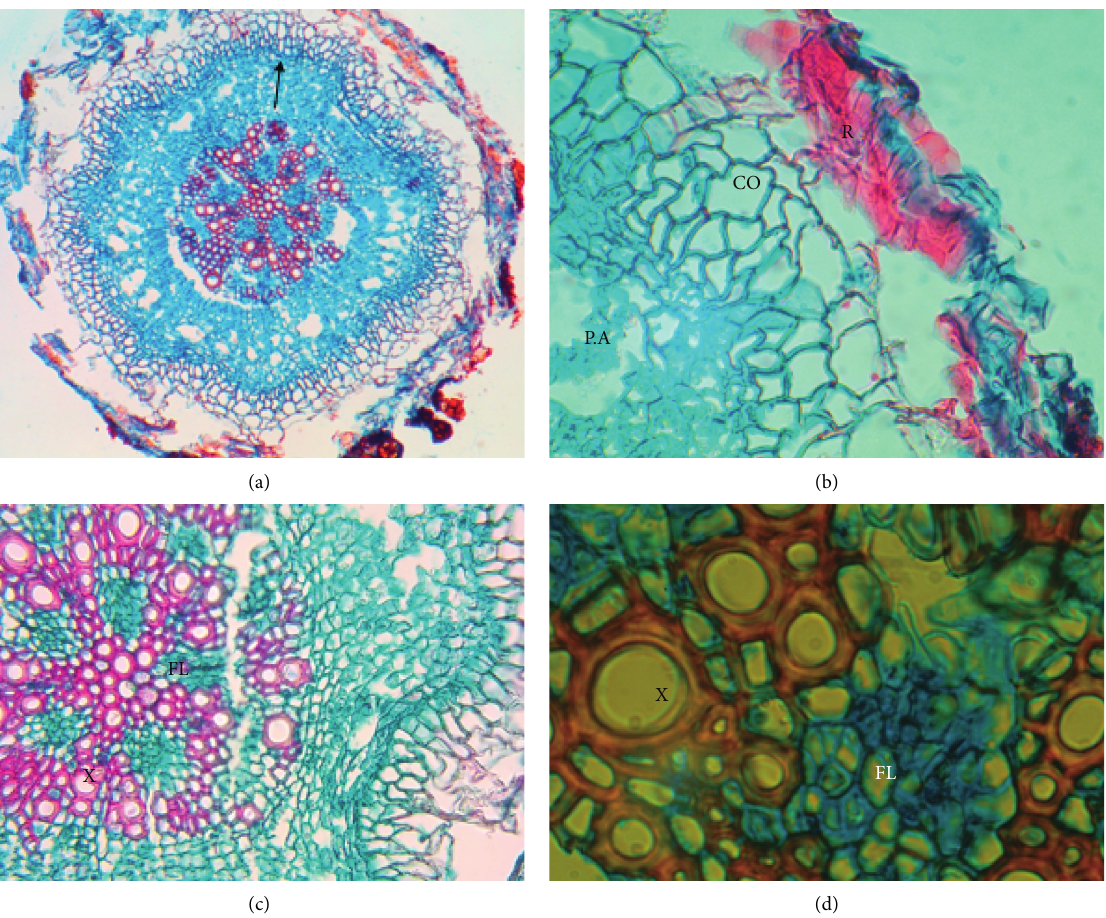
Figure 7: Image of root cross-section of specimen from El Yali National Reserve. General view of the root (a); rhizodermis (R), collenchyma (CO), and aeriferous parenchyma (PA), 10X magnification (b); phloem (FL) and xylem (X), 10X magnification (c); xylem (X) and phloem (FL) in 40X magnification (d)